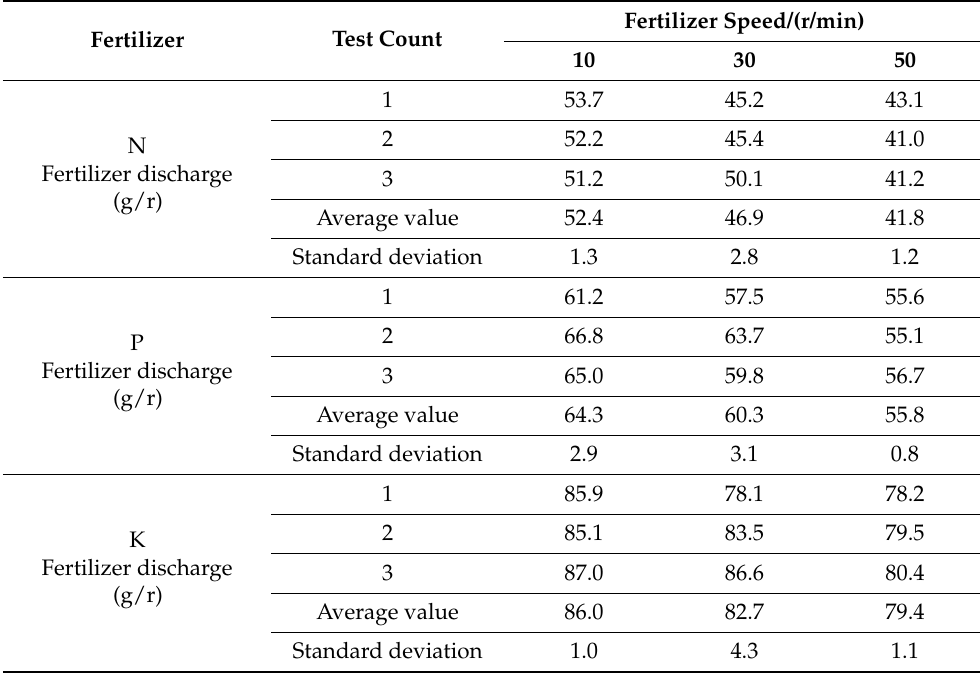
Table 2. Fertilizer discharge measurement test